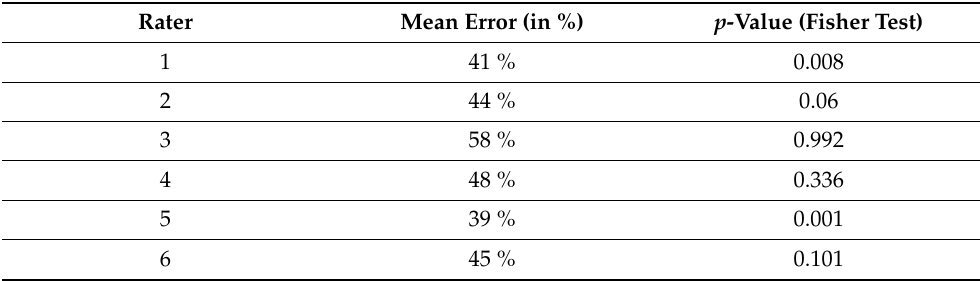
Table 4. Mean error and the statistical significance for each